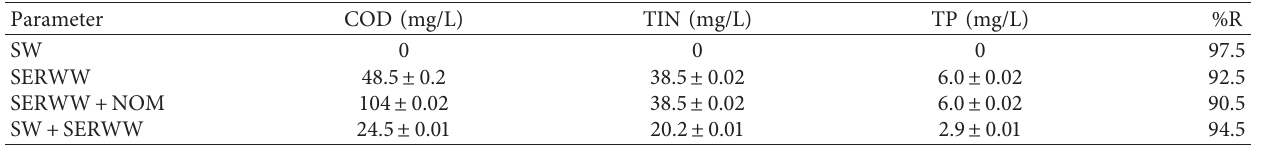
Figure 6: The consequences of (a) PZC, (b) pH, and (c) agitation speed for the removal of Pb(II) ions from wastewater at optimum initial concentration of Pb(II) ions (30mg/L), contact time of 120min, temperature of 25 ° C, and CNM and NaIO 4 dosage of 1 (g), Table 2: Effect of different parameters on the Pb(II) ions removal.